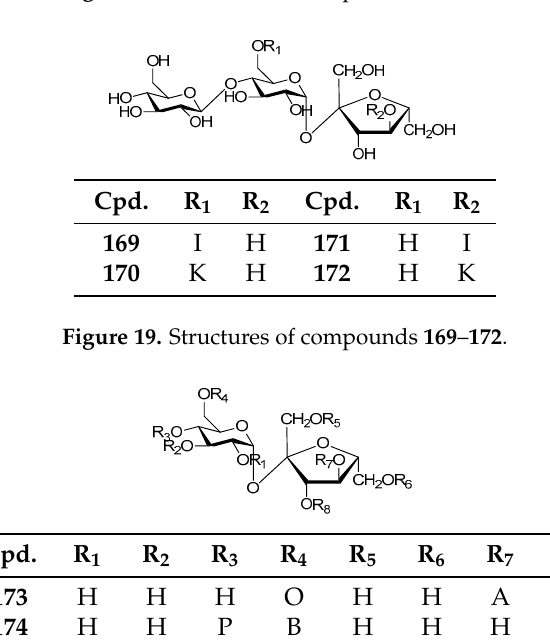
Figure 20. Structures of compounds 173 – 174 .